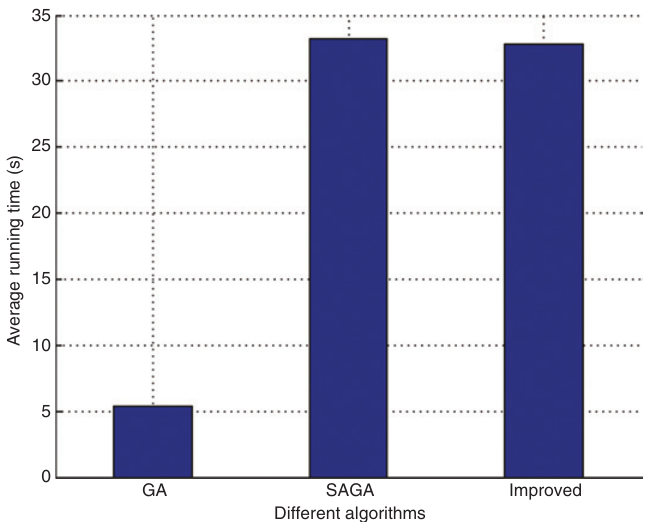
Figure 7. Running Time of Different Methods.